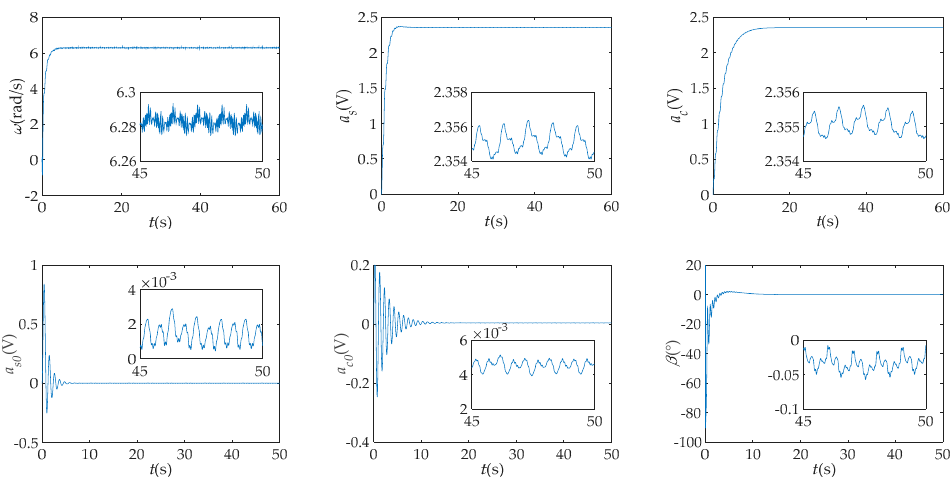
Figure 14. Estimations of angular velocity and imperfect parameters before filter (Group 1).